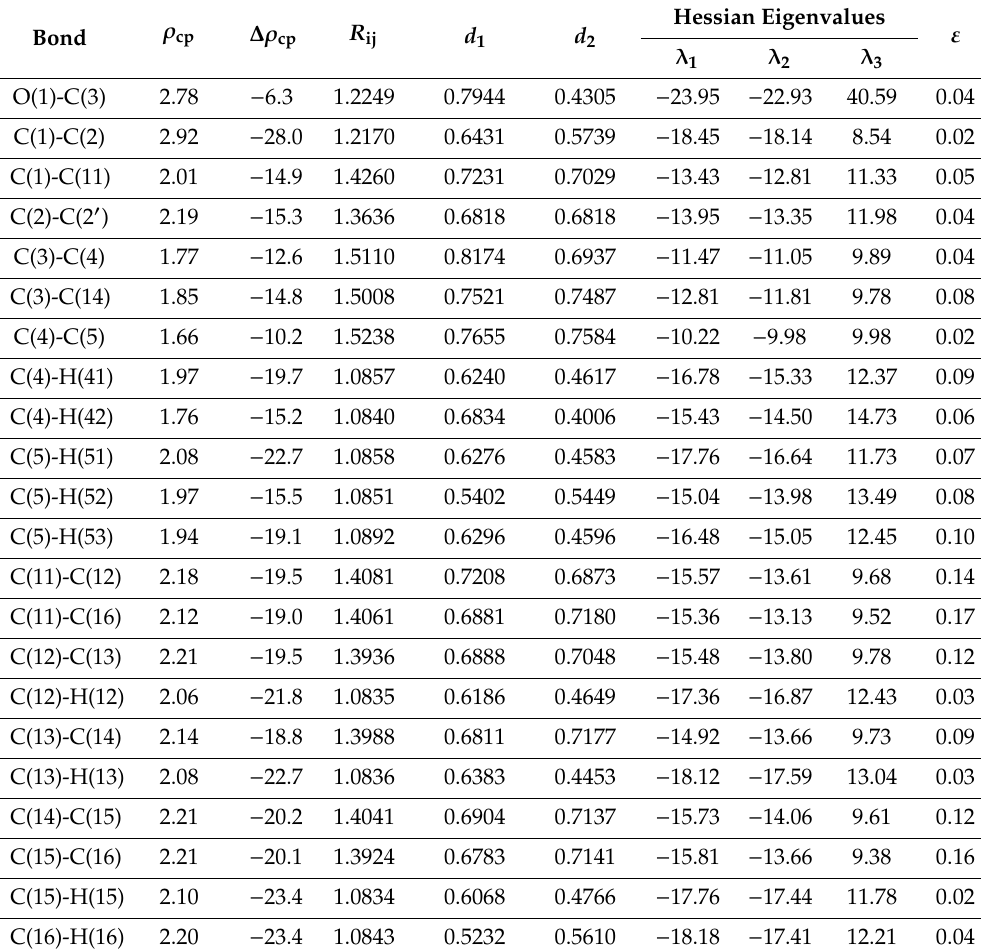
Table 3. Topological parameters of the charge distribution in 1